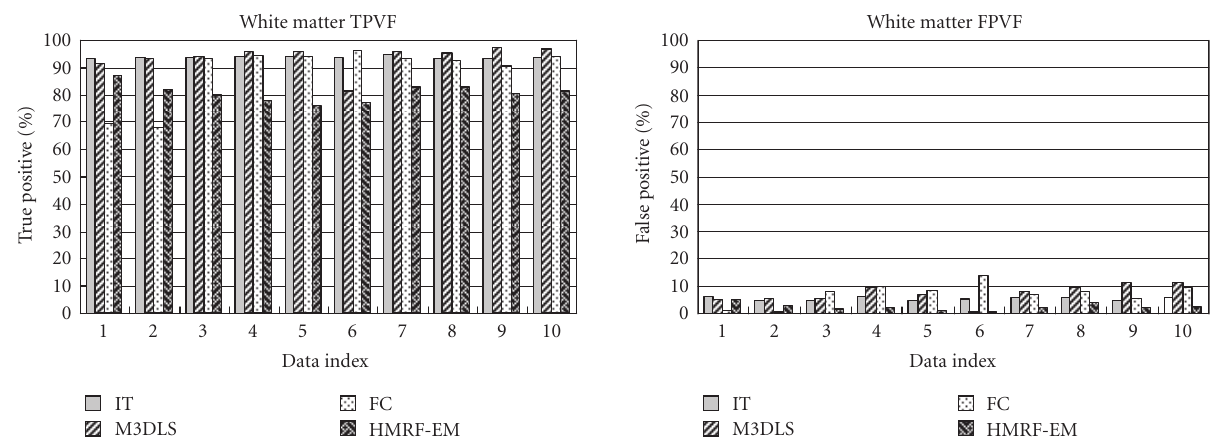
Figure 9: TPVF and FPVF errors for segmentation of